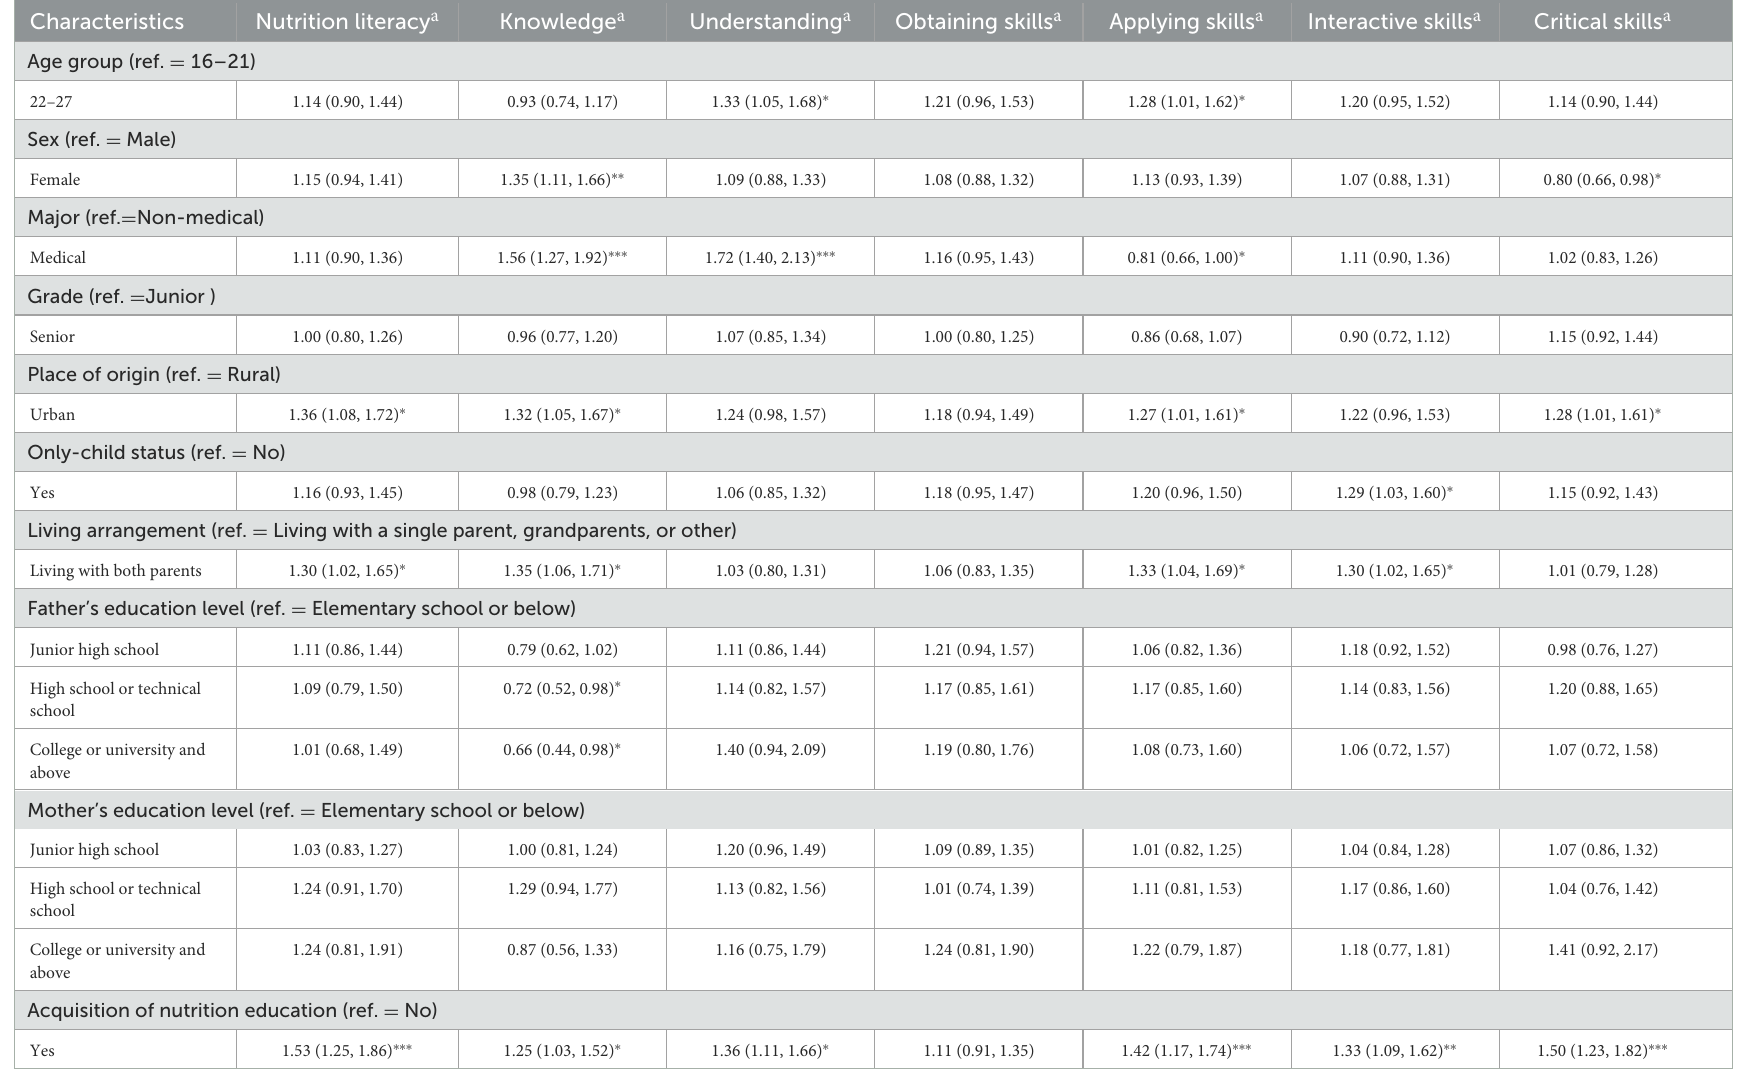
TABLE 2 Multivariate analysis for variables associated with total nutrition literacy and its six dimensions.